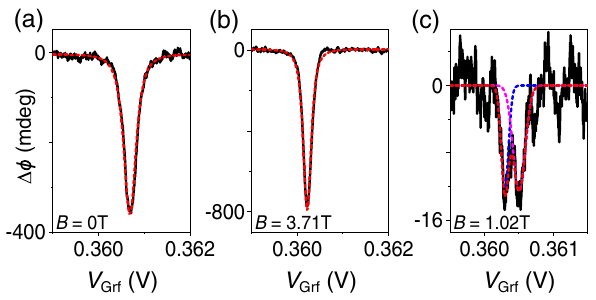
FIG. 7. Phase response as a function of V fields. The dashed lines indicate fits to the data enabling the determination of Δ . (a) – (c) Singlet, quintet, and triplet signals, i